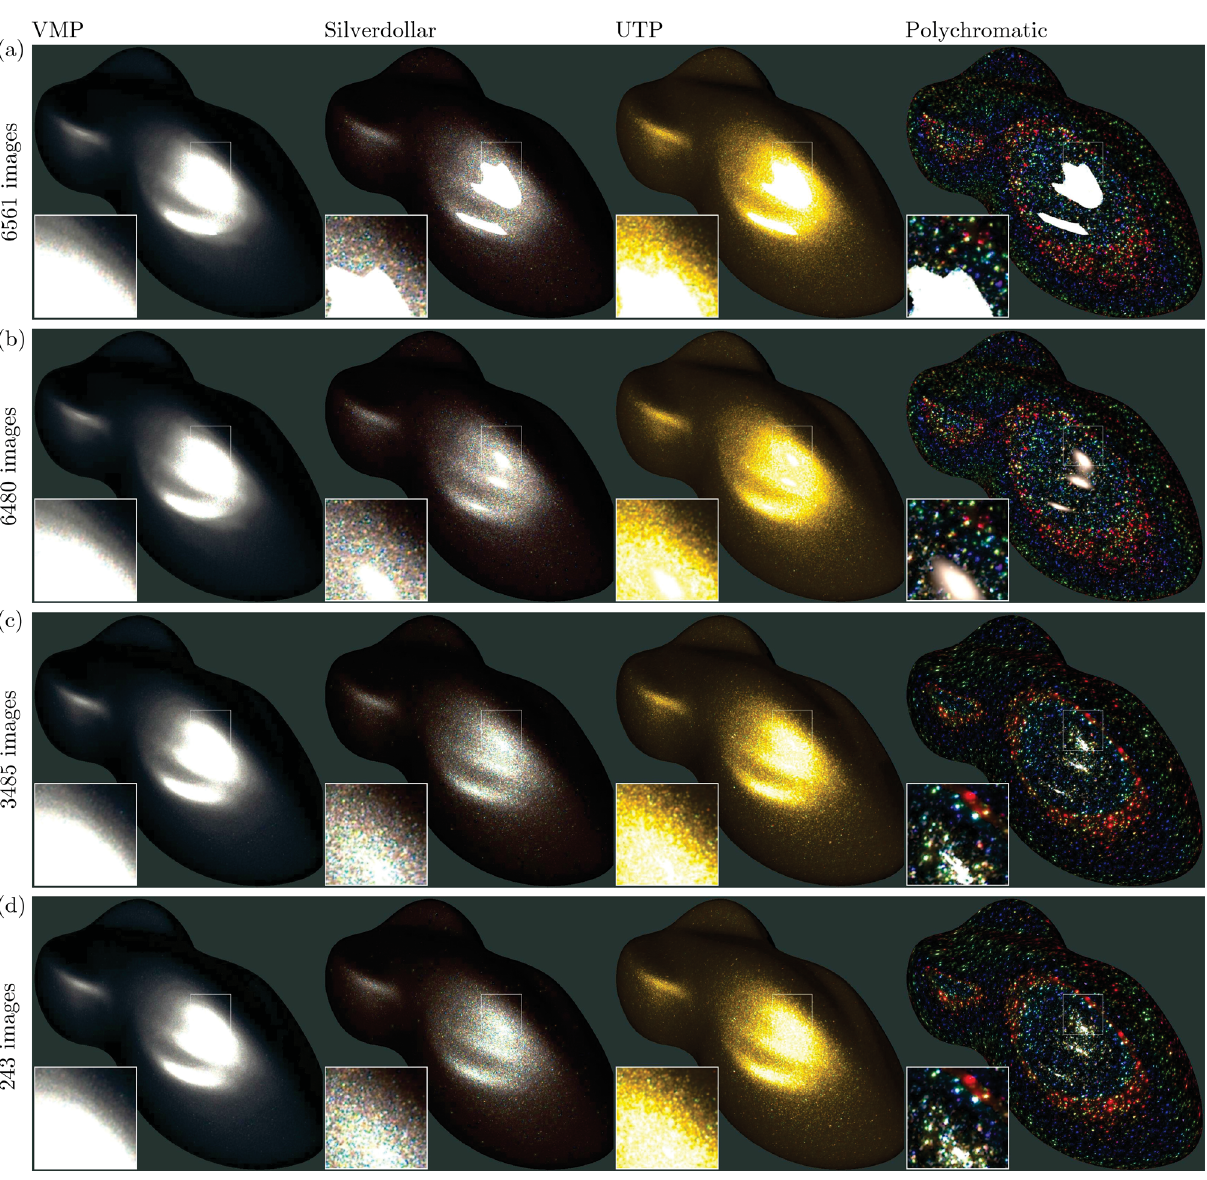
Fig. 8 Rendering of captured spatially-varying appearance using different representations: (a) raw BTF measurements, (b) BTF measurements with specular highlight represented by Fresnel reflection, (c) isotropic measurements: constant ϕ h , (d) isotropic bivariate measurements: constant ϕ h and ϕ d